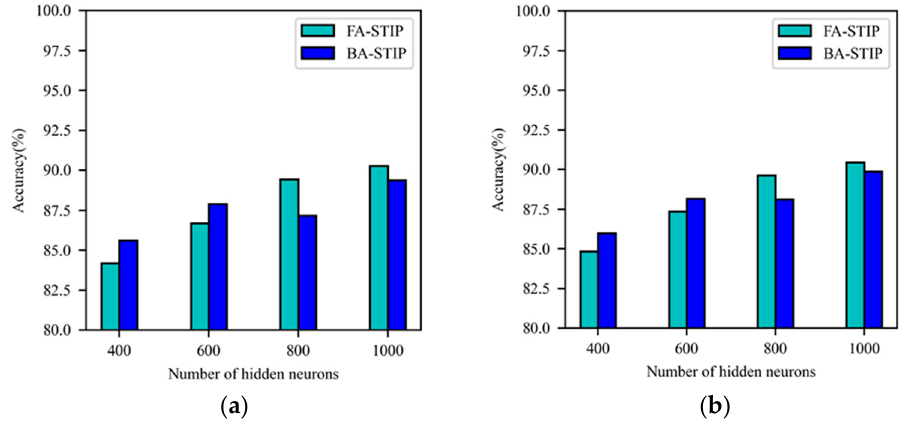
Figure 7. Comparison of learning performance for three STIP-based algorithms with inverse multi- quadratic kernel function. ( a ) The accuracy of the training set; ( b ) the accuracy of the testing set.